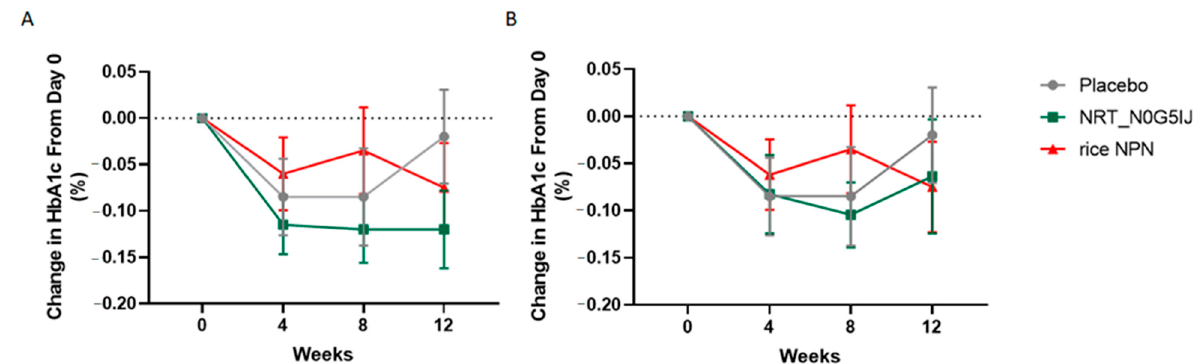
Figure 6. NRT_N0G5IJ treatment decreased HbA1c percentage in a prediabetic population. NRT_N0G5IJ (15 g/day) administration elicited a significant decrease in HbA1c relative to either placebo or control rice NPN in ( A ) per protocol (PP) or ( B ) intention to treat (ITT) populations (GEE analysis; data are represented as the mean ± SEM).